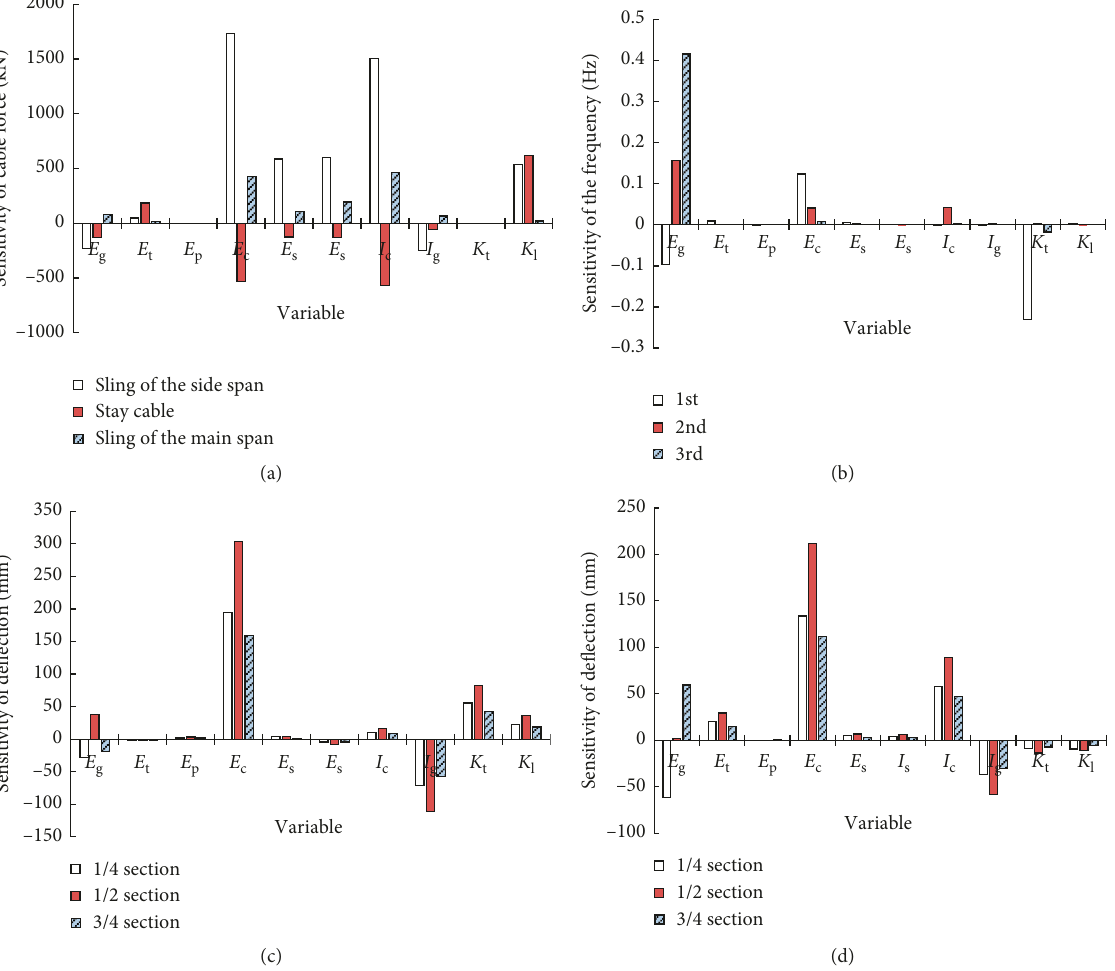
Figure 8: Sensitivity analysis. (a) Cable force. (b) Natural frequency. (c) Deflection in symmetric loading for case 1. (d) Deflection in symmetric loading for case